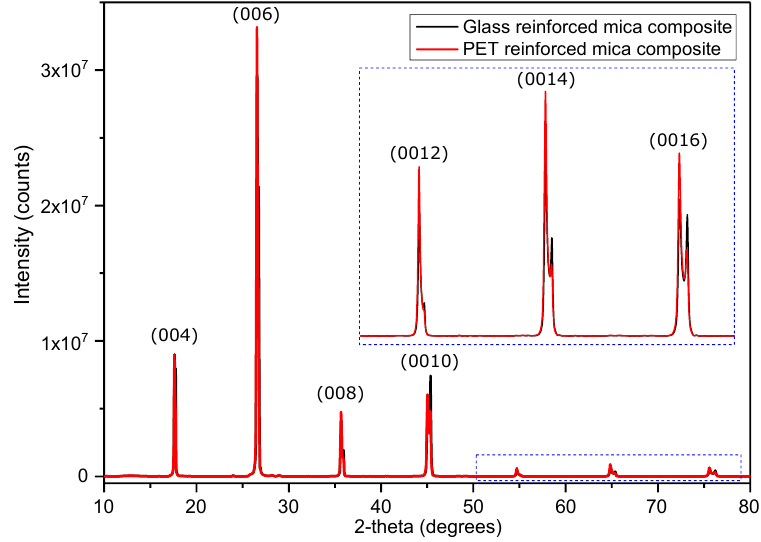
Figure 9. X-ray diffraction patterns of mica